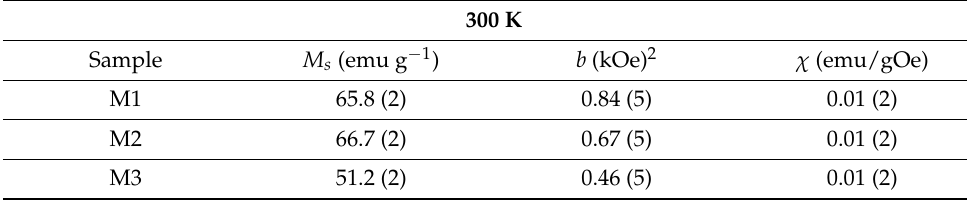
Table 3. Fit parameters from the LAS equation at high magnetic fields (70